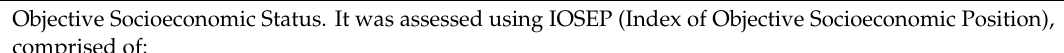
Table 1. Selected variables and the instruments used for their assessment in the present study. Measures to Assess Socioeconomic